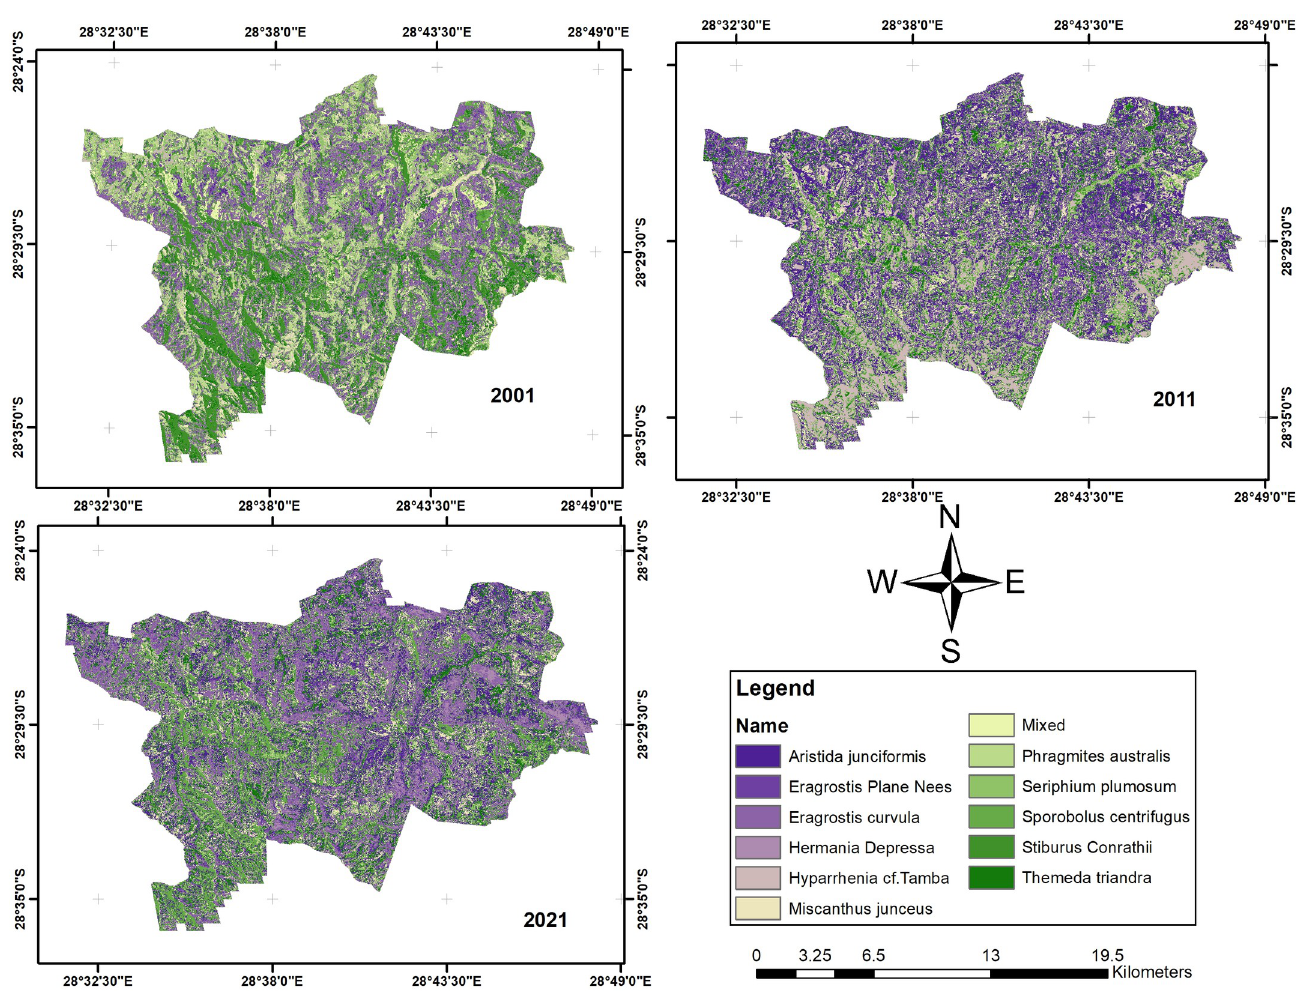
Fig 3. The map of grass species. (a) derived from Landsat 7 ETM+, (b) derived from the ASTER MI, (c) derived from Sentinel-2 MSI.